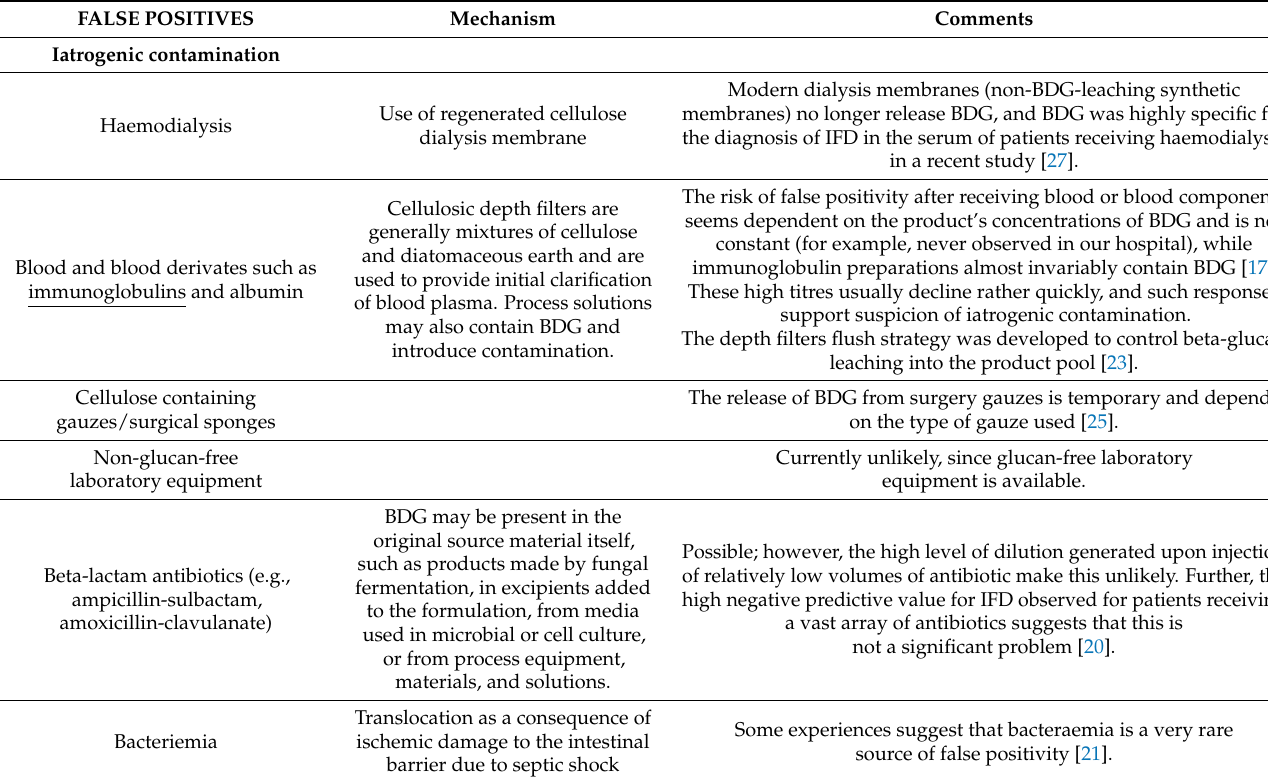
Table 2. Potential causes of false positive and false negative results of serum BDG; underlined cases are considered as clinically important and potentially frequent